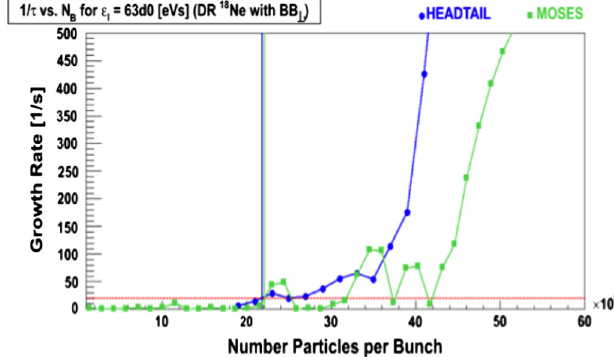
FIG. 48. Growth rate according to HEADTAIL (blue) and MOSES (green) as a function of bunch